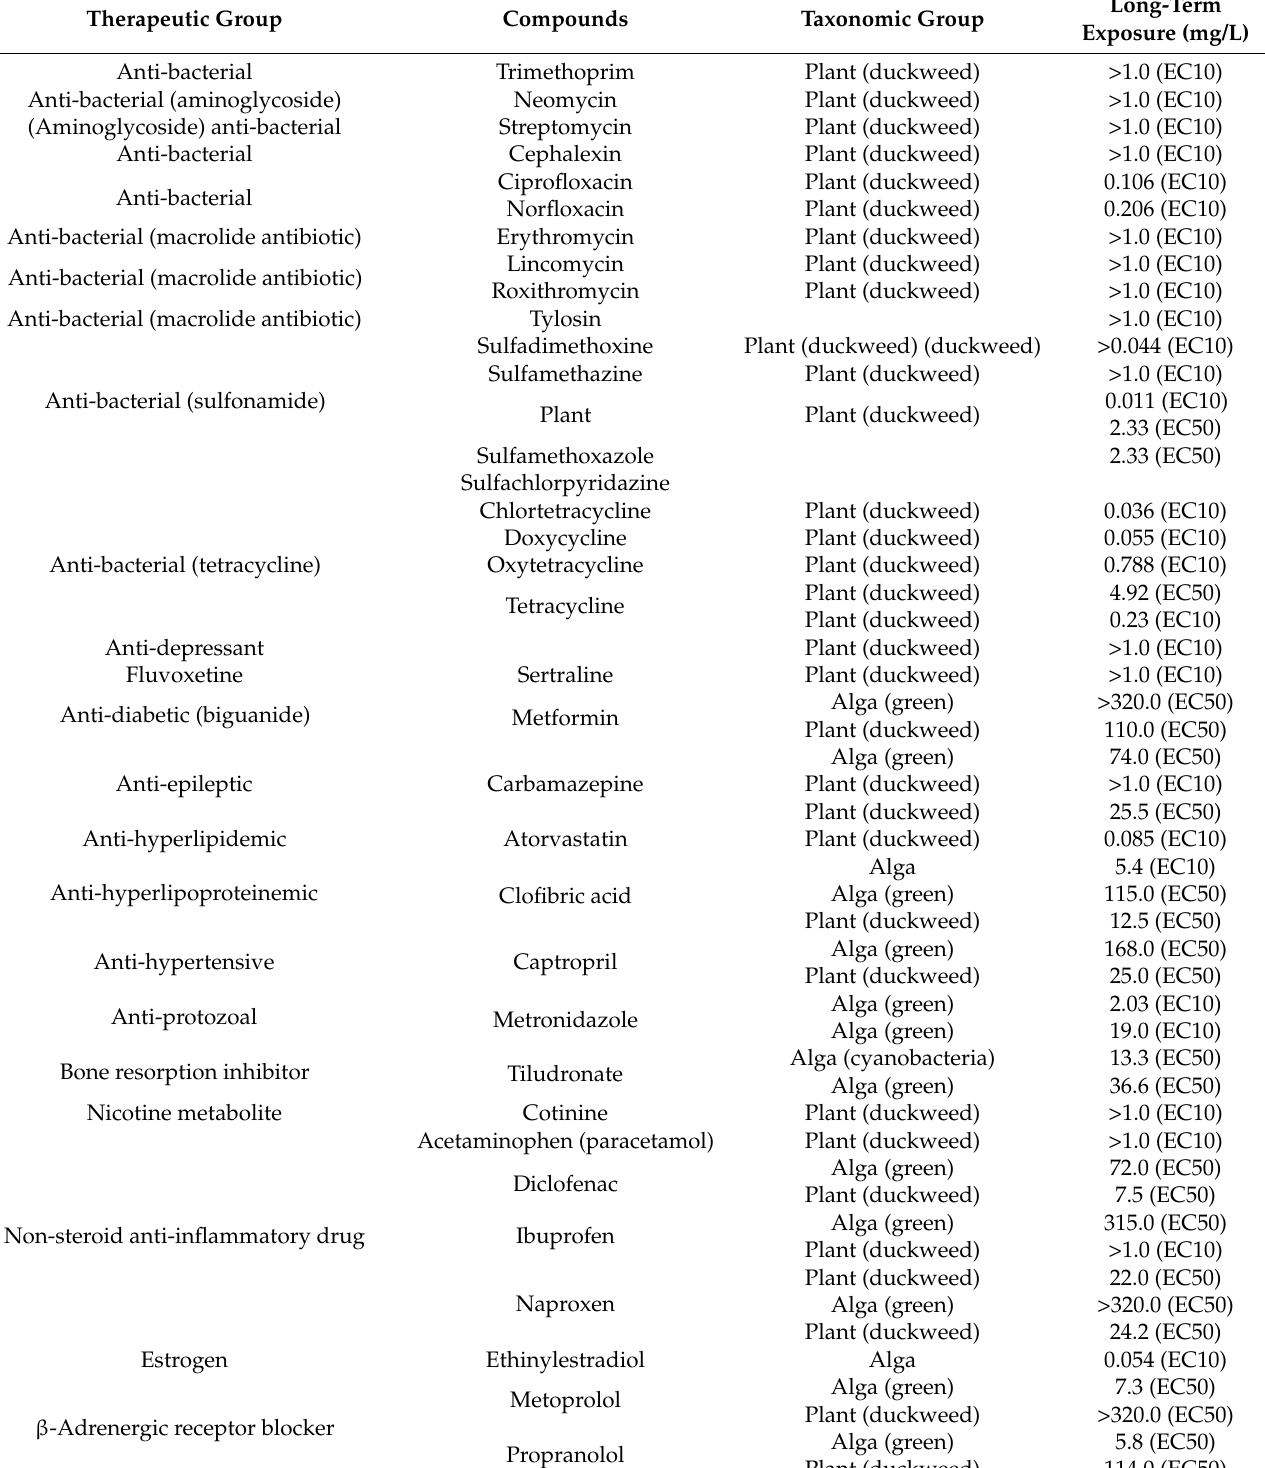
Table 2. Toxicities of the drugs and pharmaceuticals residues in aquatic organisms and plants